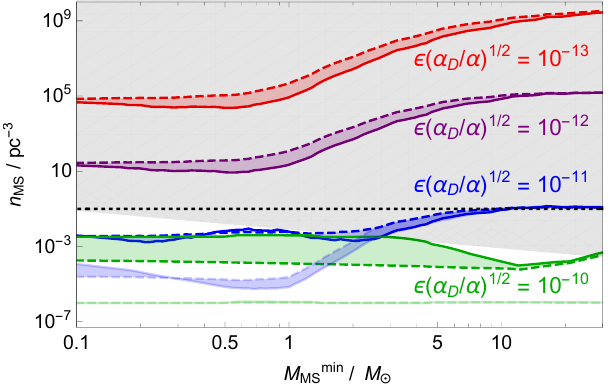
Figure 9. Gaia constraints on SM-like mirror star number density, for β = − 1 mass function with minimum stellar mass M (dashed), or delta function mass distribution (solid). The coloured MS curves correspond to four different values of the kinetic mixing parameter times dark coupling constant. The shading indicates the effect of the unknown mirror star mass function. The more (less) opaque curves correspond to the current (optimistic future) constraints derived from the optically thick mirror stars. In the gray region, the mirror star mass density excluded by Gaia exceeds the local dark matter density. The black dotted line is the local number density of regular